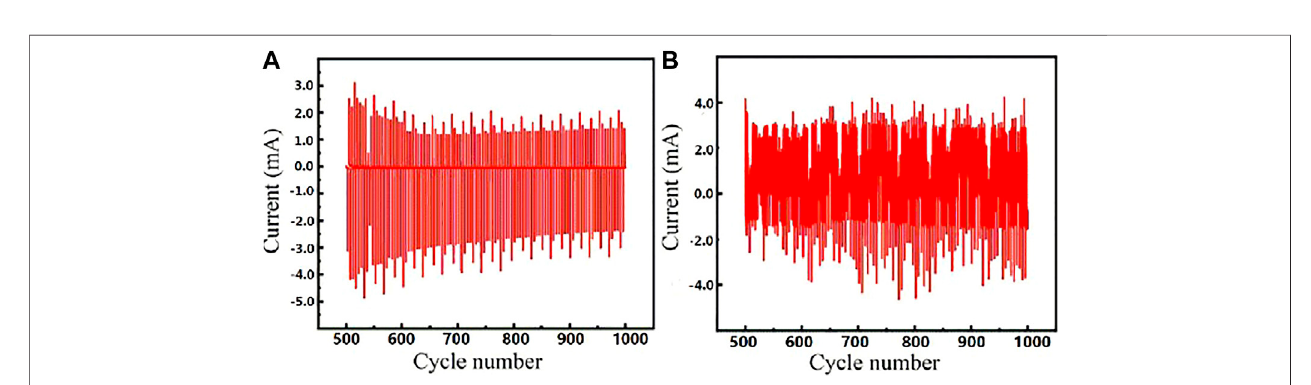
FIGURE 7 | The cyclic stability of FECD-EP (A) and FECD-composite (B) .